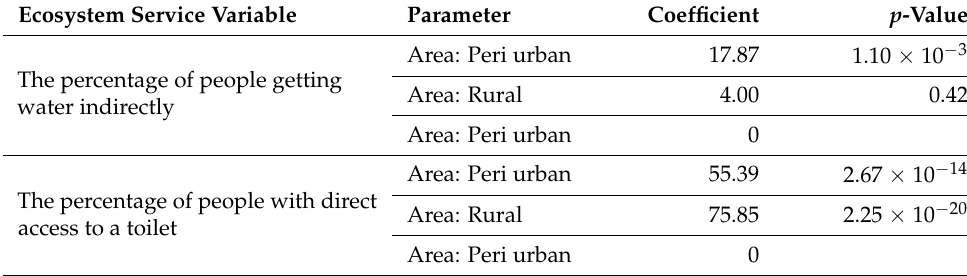
Table A8. Direct and indirect access to